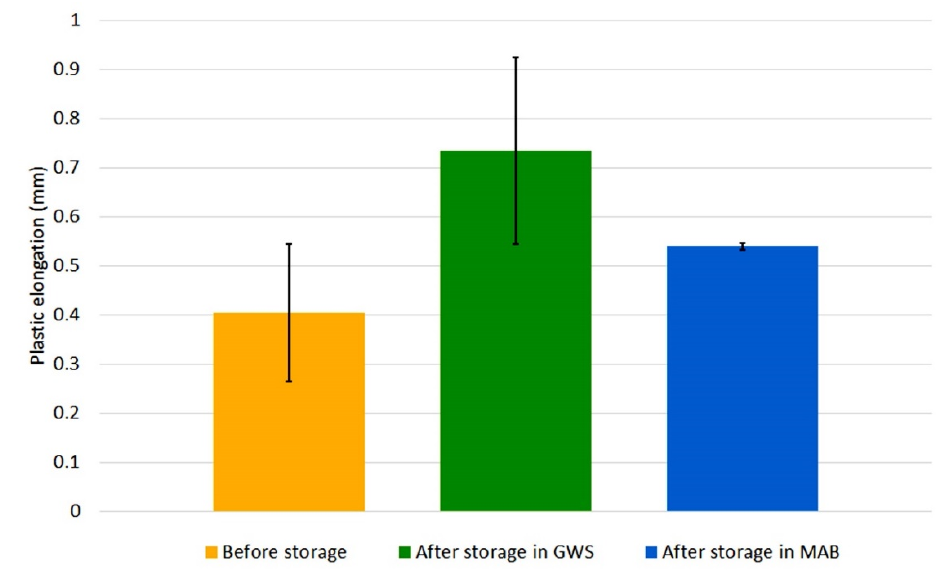
Figure 8. Change in plastic elongation of welds made with A wire, caused by storage for 1 month.